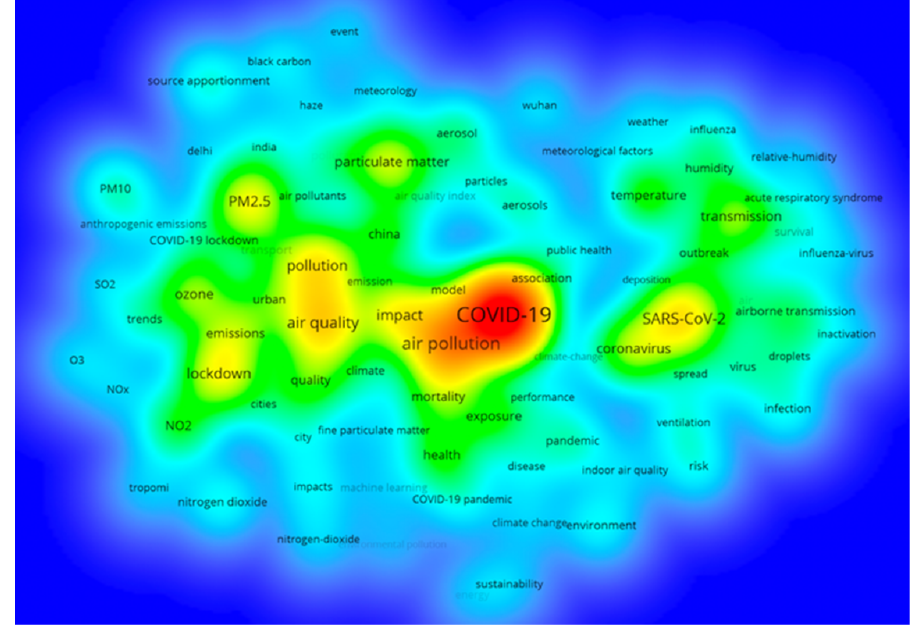
Figure 6. Keyword density visualization.